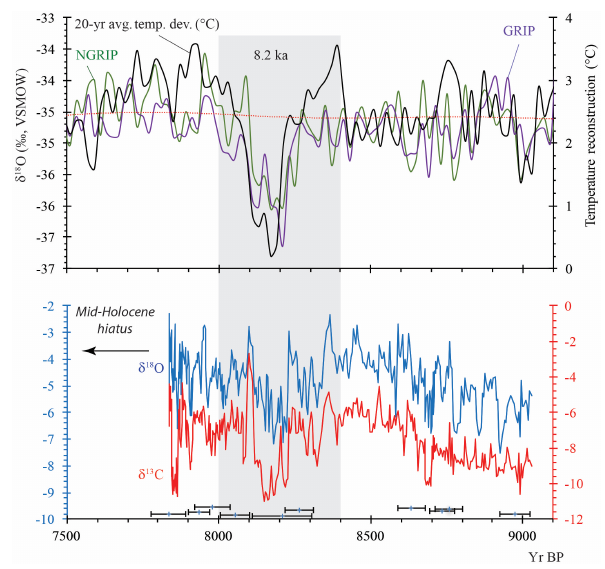
Figure 10. The 8.2kaBP event in Madagascar. Oxygen isotope record from Greenland (GRIP and NGRIP) ice cores (Vinther et al., 2009) compared with Stalagmite ANJB-2 δ 18 O and δ 13